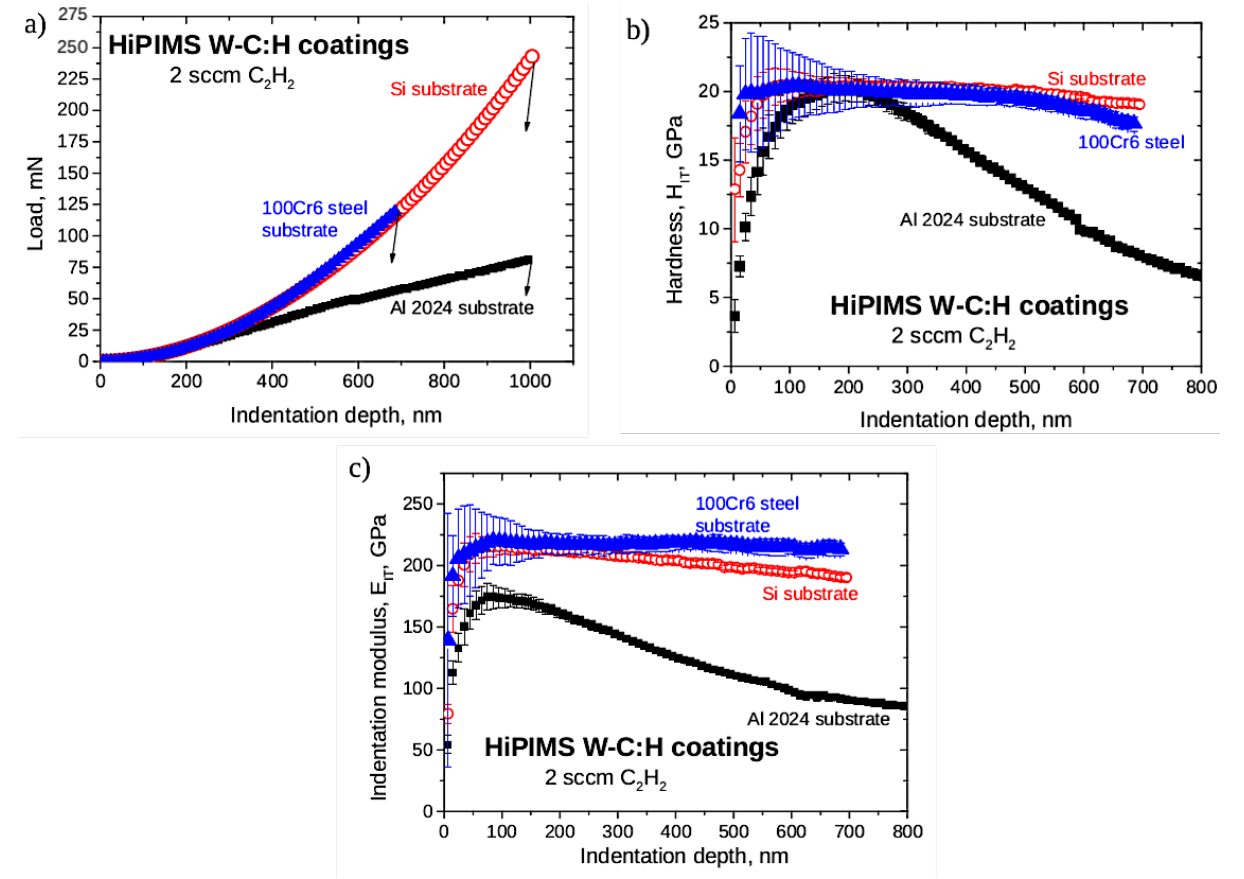
Figure 1. Load – indentation depth curves from the nanoindentation tests on the HiPIMS W-C:H coatings deposited with 2 sccm C H on Si wafer, 100Cr6 bearing steel and Al 2024 alloy substrates – a) The depth profiles of hardness – 2 2 b) and indentation modulus –